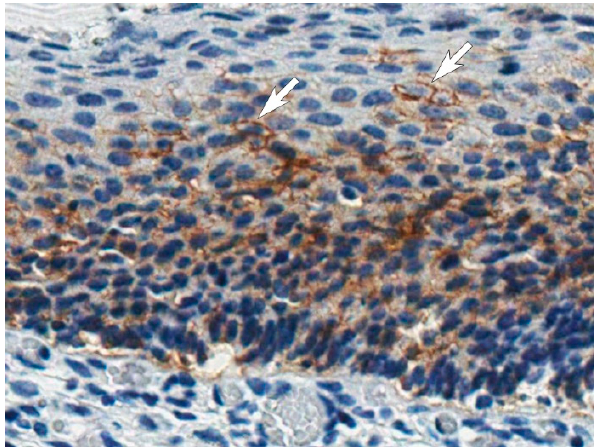
Figure 5. Immunohistochemical CA IX detection in the tissue section of cervical carcinoma in situ using MAb H7. Staining of the cellular membranes is evident in several regions (shown by white arrows). Magnification × 40.